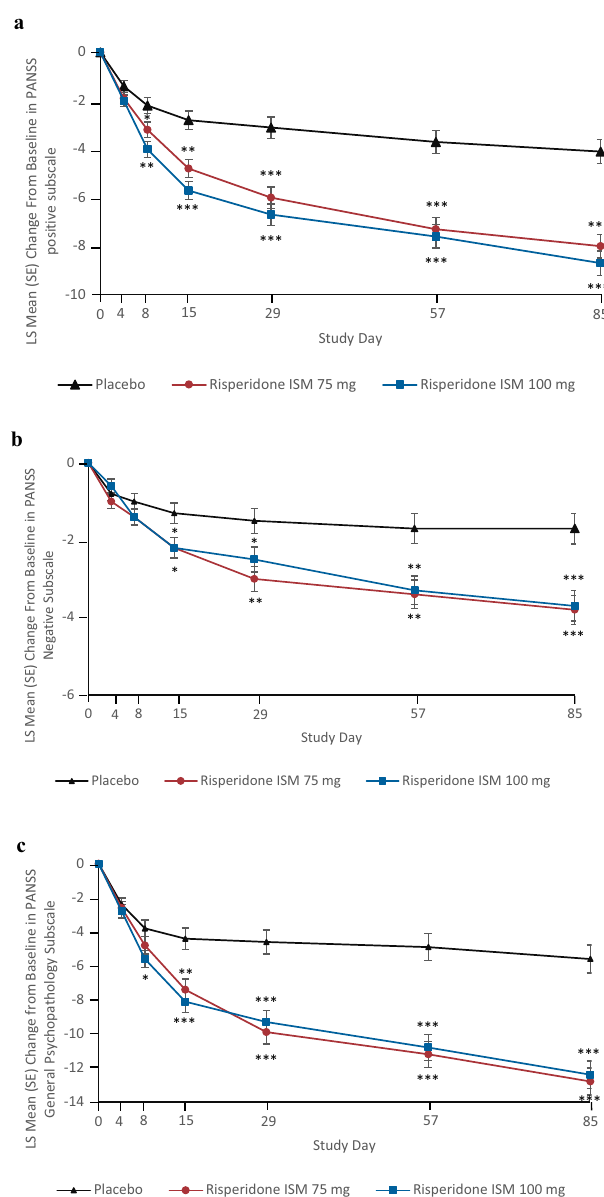
Fig. 3 LS mean change from baseline in PANSS subscale score (mITT population). a PANSS positive subscale, where mean PANSS positive subscale score at baseline for placebo = 25.3 (SD: 3.11), for Risperidone ISM 75 mg = 25.1 (SD: 3.15) and for Risperidone ISM 100 mg = 25.5 (SD: 3.40). The error bars represent SE and P values are for Risperidone ISM 75 mg and Risperidone ISM 100 mg dose group versus placebo (* p < 0.05, ** p < 0.001, *** p < 0.0001). b PANSS Negative Subscale, where mean PANSS score at baseline for placebo = 23.5 (SD: 3.34), for Risperidone ISM 75 mg = 23.3 (SD: 4.19) and for Risperidone ISM 100 mg = 23.1 (SD: 3.73). The error bars represent SE and P values are for Risperidone ISM 75 mg and Risperidone ISM 100 mg dose group versus placebo (* p < 0.05, ** p < 0.01, *** p < 0.001). c PANSS General Psychopathology Subscale, where Mean PANSS Score at baseline: for placebo = 47.7 (SD: 4.90), for Risperidone ISM 75 mg = 47.8 (SD: 5.48) and for Risperidone ISM 100 mg = 47.4 (SD: 5.06). The error bars represent SE and P values are for Risperidone ISM 75 mg and Risperidone ISM 100 mg dose group versus placebo (* p < 0.05, ** p < 0.001, *** p < 0.0001).